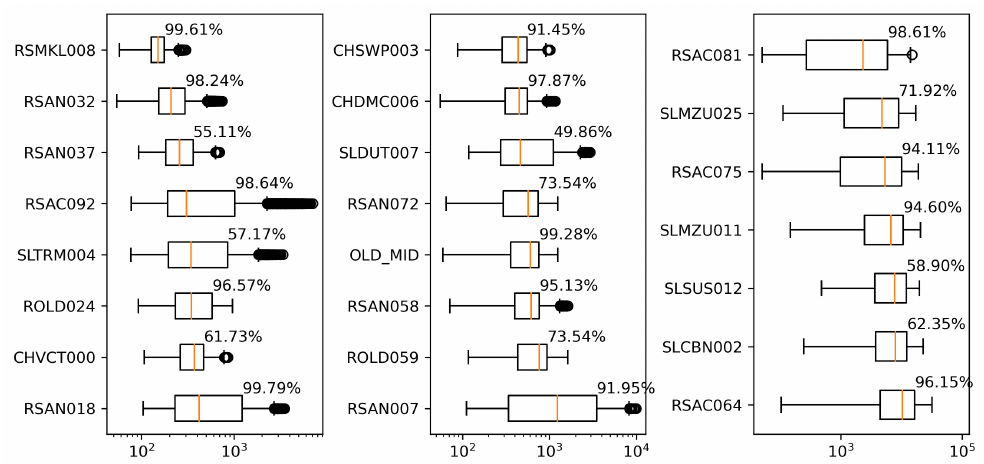
Figure 2. Boxplot of salinity observations (represented by electrical conductivity) at study locations, sorted by their medians. Numbers next to each station’s box represent the ratios of available obser- vations in the dataset during the 20-year study period. Each box represents the interquartile range from the 25th to the 75th percentiles. The line inside each box represents the median value. The open circles represent outliers.